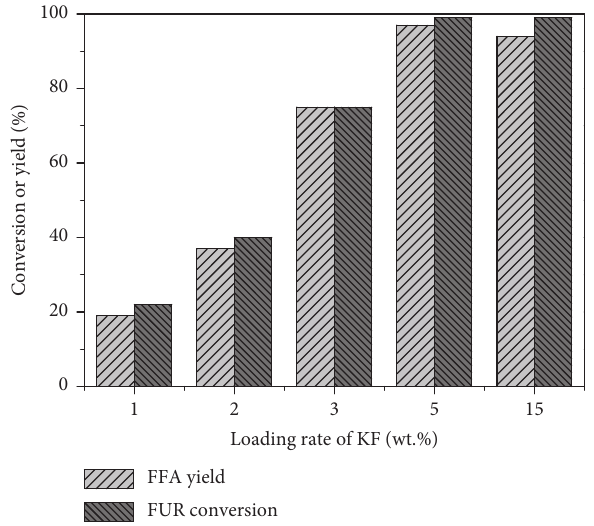
Figure 3: Effect of KF loading rate of KF/ZrO 2 on the reduction of FUR to FFA. Reaction conditions: 0.5mmol FUR, 25mg KF/ZrO 2 , 2.5 equiv. H − of PMHS, 2 mL DMF, 25 ° C, and